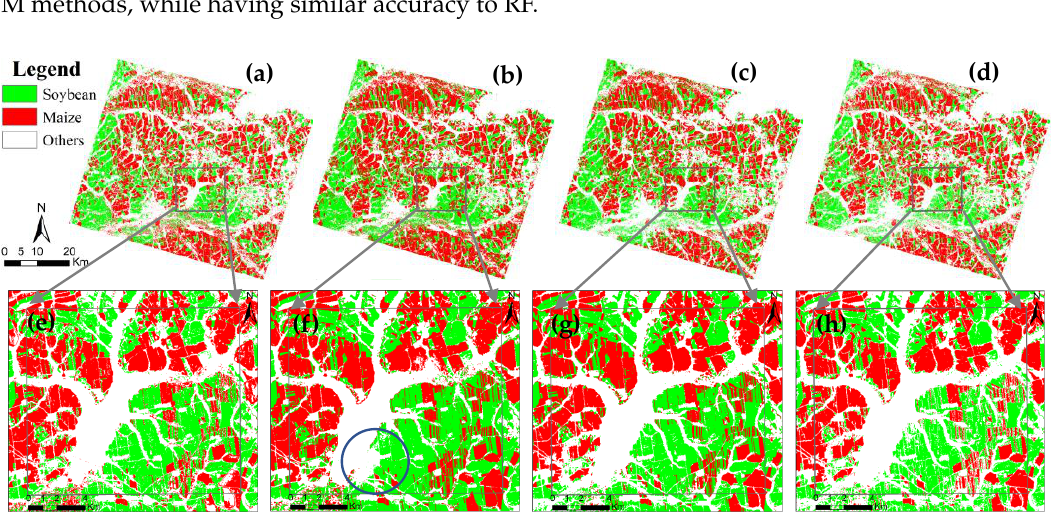
Figure 11. Crop distribution results of the study area based on FFE ( a , e ), MLC ( b , f ), SVM ( c , g ), and RF ( d , h ) approaches.